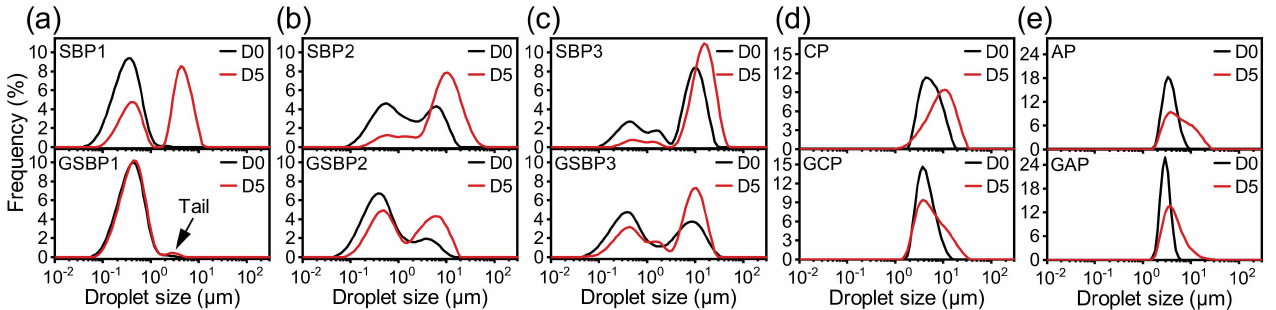
Figure 3. Droplet size distribution of fresh (D0) and stored (D5) emulsions stabilized by SBP1/GSBP1 ( a ), SBP2/GSBP2 ( b ), SBP3/GSBP3 0 ( c ), CP/GCP ( d ), and AP/GAP ( e